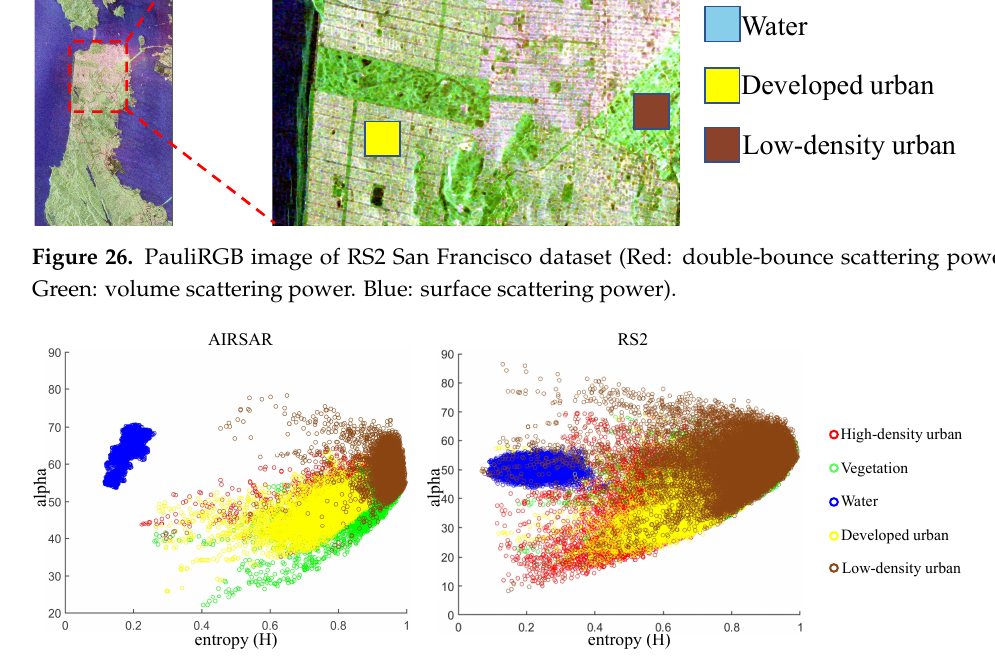
Figure 27. H-Alpha plots of two San Francisco